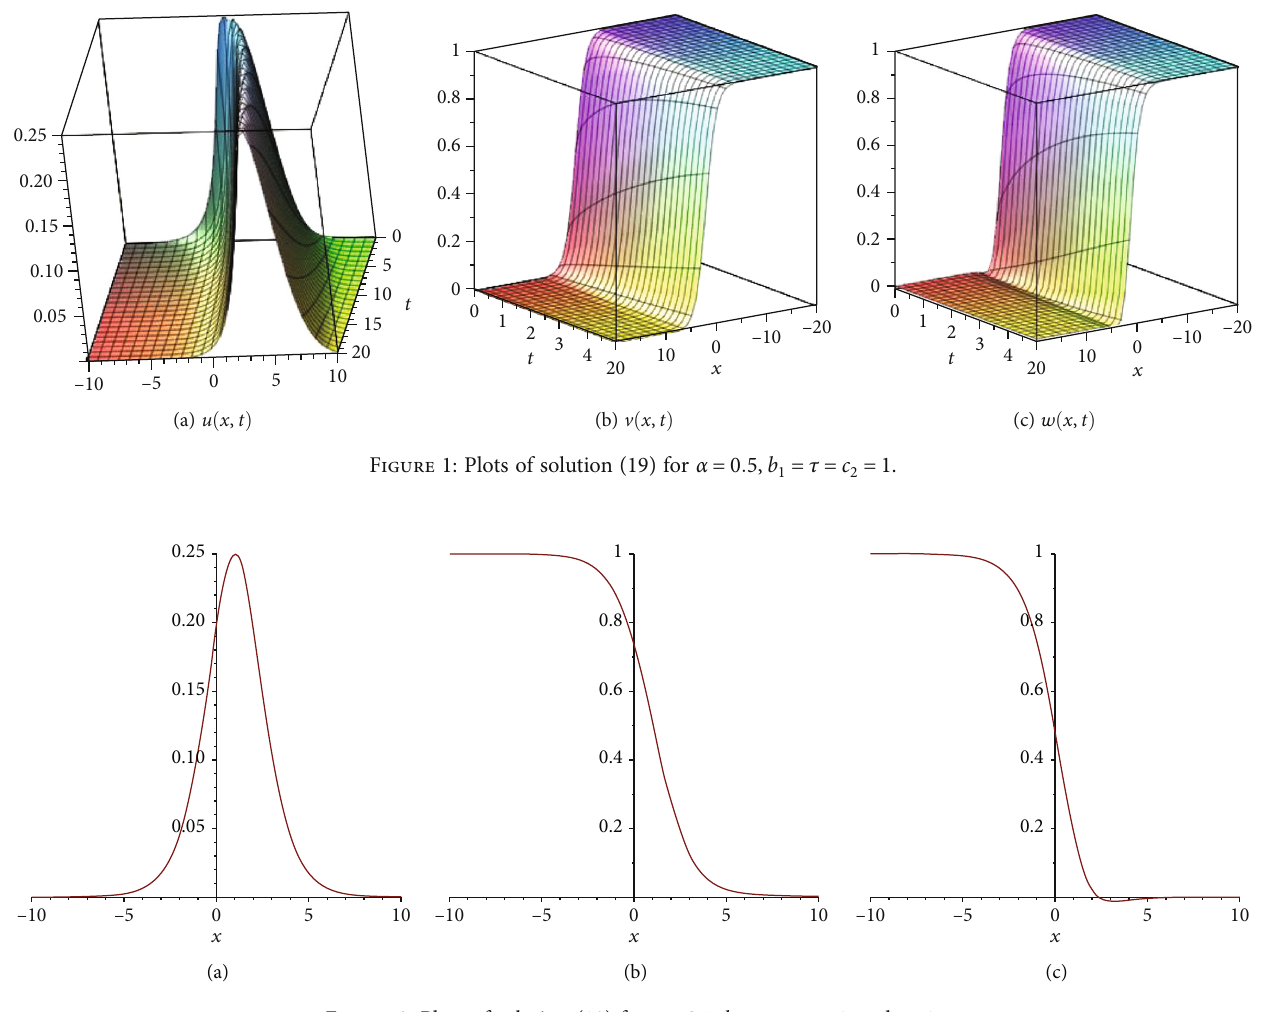
Figure 2: Plots of solution (19) for α = 0 : 5, b